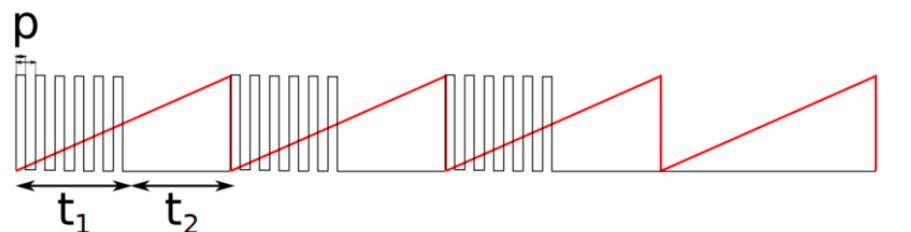
Figure 11. Signal of a vibrator. On this schema, PWM and pulse periods are not represented with the same scale. The signal corresponds to the parameters p = 45%, t 1 = 0.3 s, t 2 = 0.3 s, n = 3. The vibrator stops after 3 pulses ( n = 3). The red signal is the signal carrying period 0.6 s.